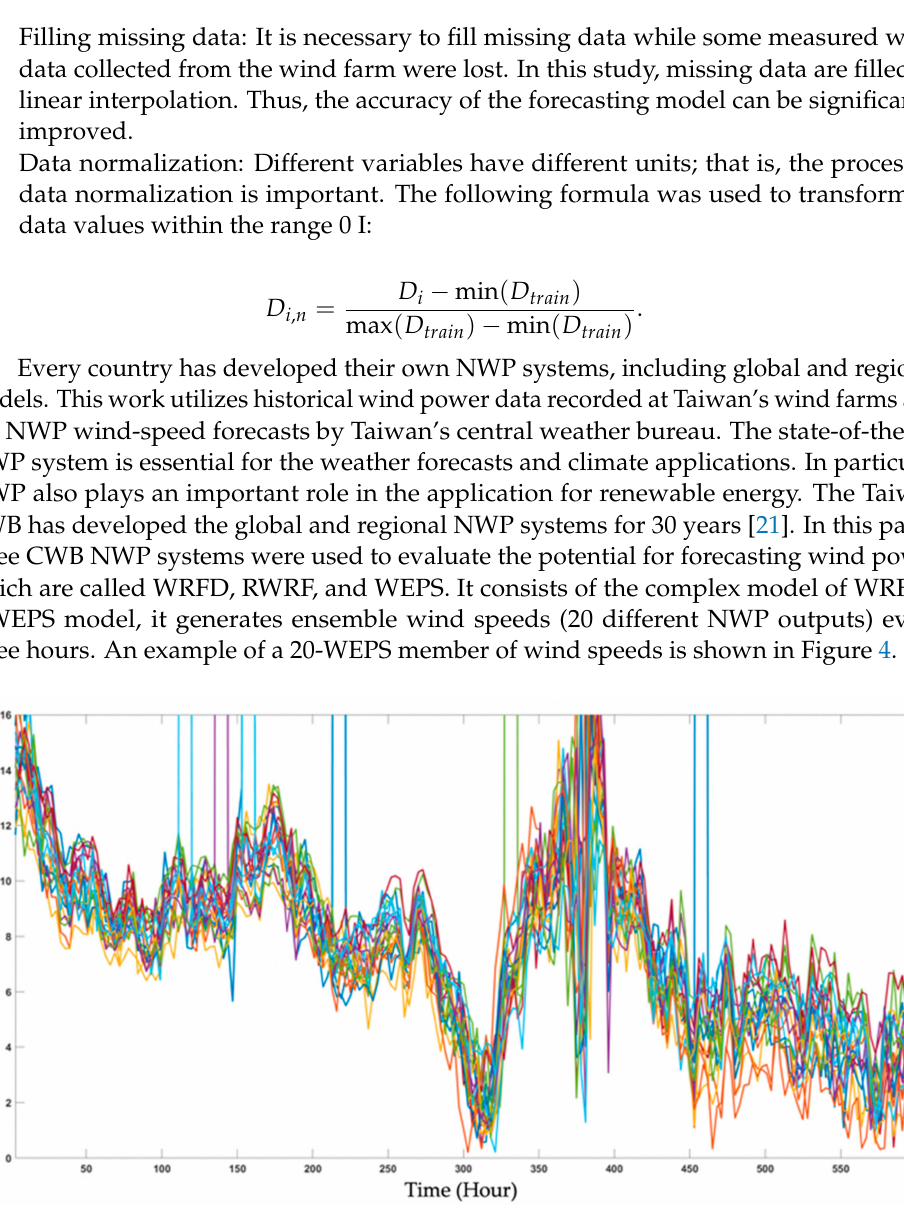
Figure 4. Example of a 20-WEPS member of ensemble wind speeds. WEPS: Weather Research and Forecasting (WRF) ensemble prediction